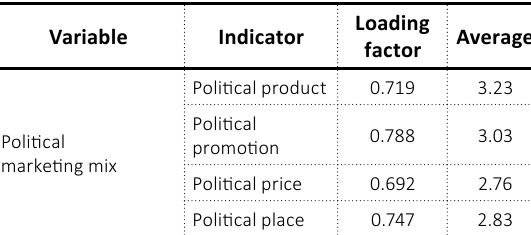
Table 1. The results of evaluation of outer model for political marketing